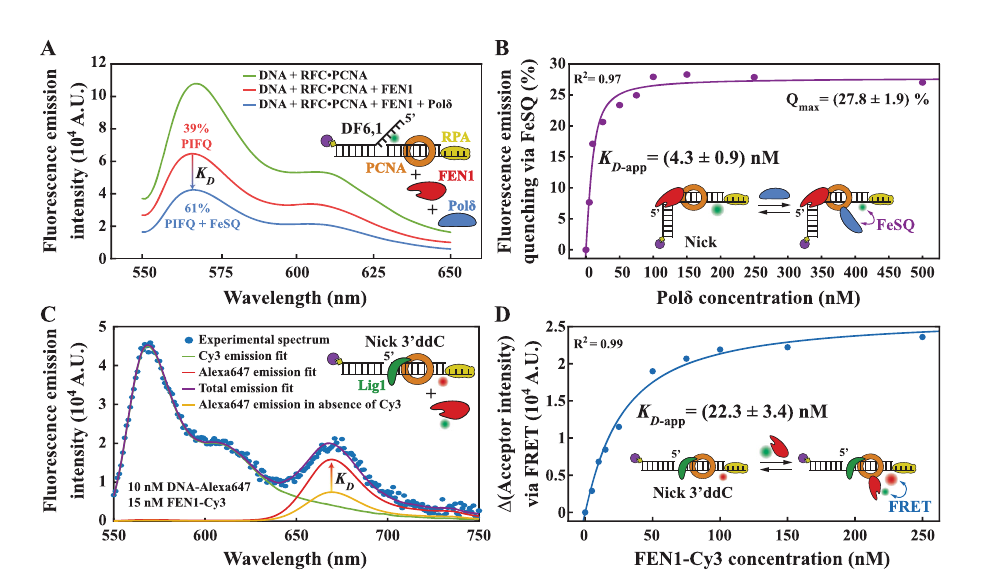
Fig. 4 | Formation of the FEN1 (cid:129) Pol δ (cid:129) PCNA and FEN1 (cid:129) Lig1 (cid:129) PCNA toolbelts. A Emission spectra of a Cy3-labeled fl ap substrate (Sub#27; Supplementary Fig. 7) in the presence of FEN1 WT (15nM) and Pol δ (250nM). FEN1 binding results